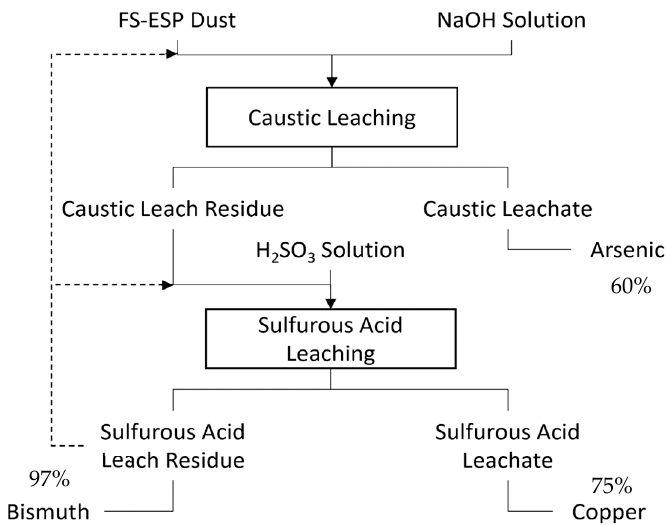
Figure 16. Proposed flowsheet for separation of copper from bismuth and arsenic. Approximate expected recoveries are shown in %.